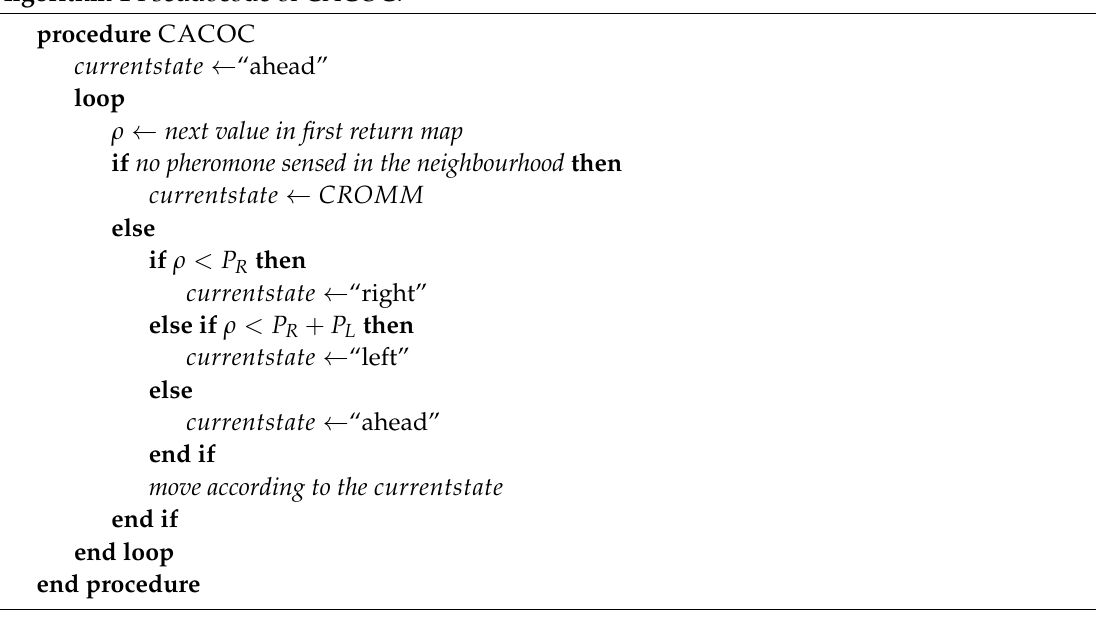
Algorithm 1 Pseudocode of CACOC.